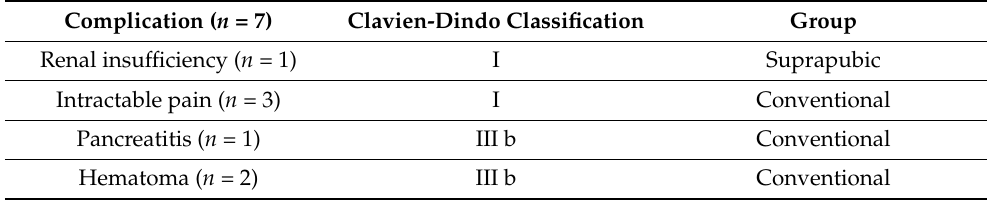
Table 2. Complications in Clavien-Dindo classification of surgical Outcome.